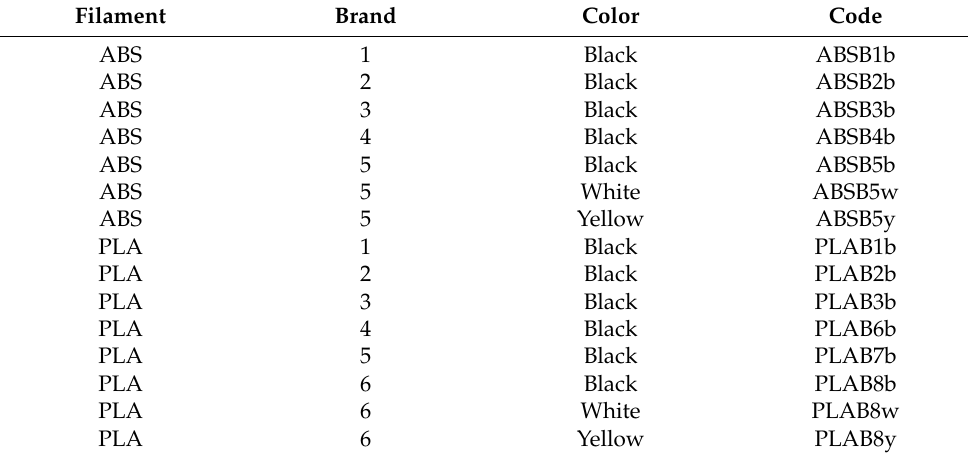
Table 2. Detailed list of tested